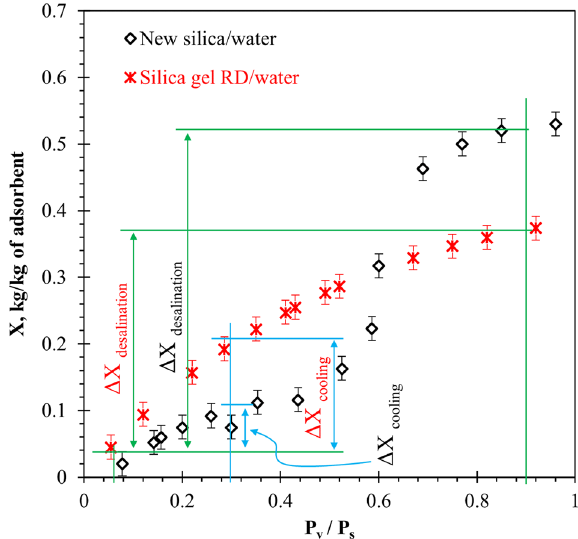
Fig. 2 Experimental water sorption isotherm of the two adsor- bents with water. The adsorption isotherm of silica RD/water (red color) and developed silica/water (black color). The change in uptake of developed silica is much higher than that of silica RD for adsorption desalination applications. The opposite trend was observed for adsorption cooling